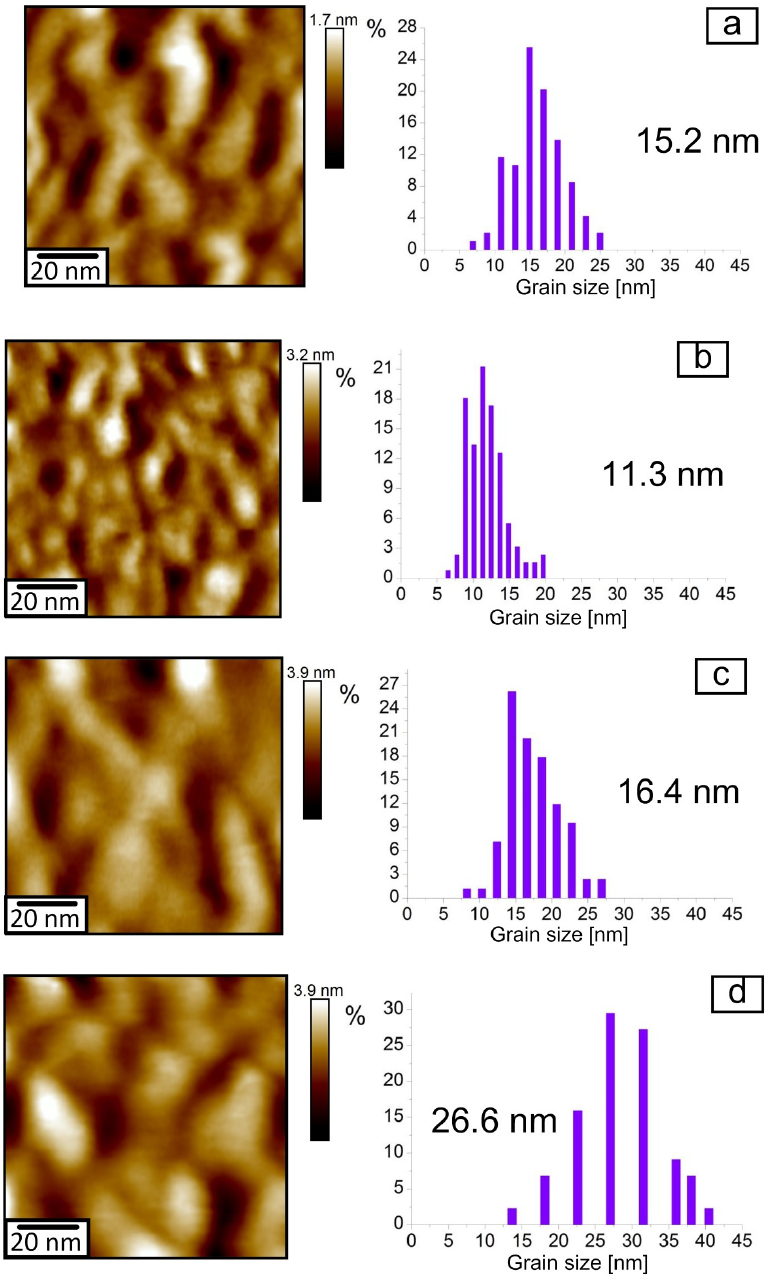
Figure 5. Atomic force microscope image (2D view) of the surface and the histograms of the distribution densities of the grain sizes of the Cr/Si structure after deposition and rapid thermal treatment: ( a ) initial film; ( b ) at the temperature of 350 ° С ; ( c ) at the temperature of 400 ° С ; ( d ) at the temperature of 550 ° С .